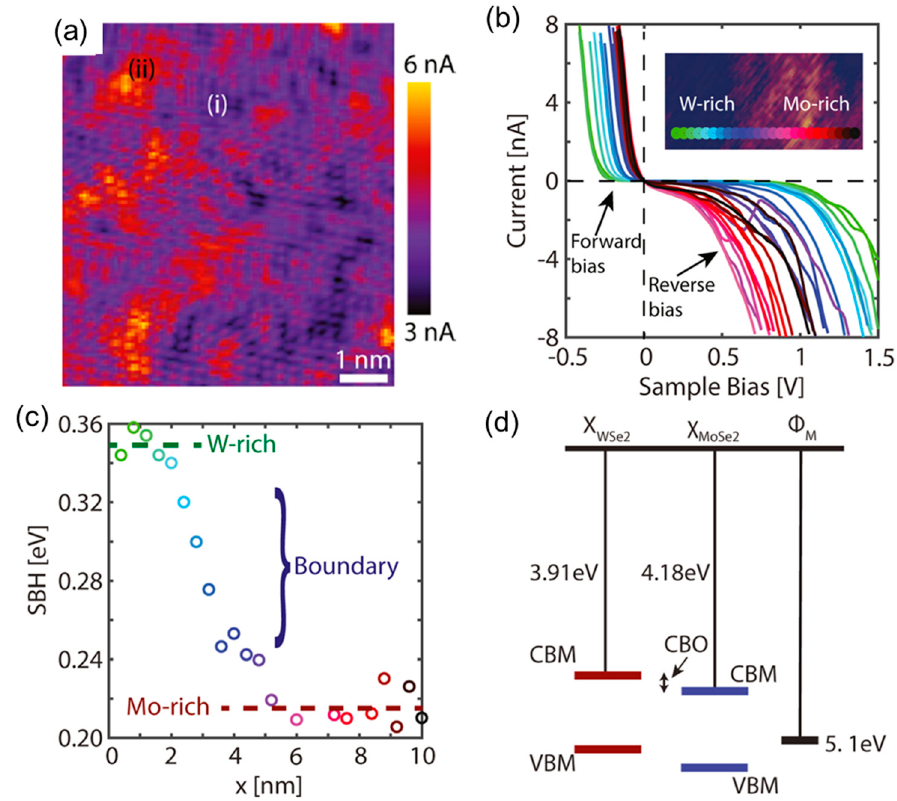
Figure 9. ( a ) C-AFM image of the surface of a Mo 0.3 W 0.7 Se 2 alloy, showing regions with different conductivities. ( b ) I-V characteristics across a W-rich/Mo-rich boundary (insert); the rainbow line indicates the positions where the I-V characteristics were recorded. ( c ) SBH as a function of the position along the line, with the color code corresponding to the exact I-V curves of panel ( b ). ( d ) Schematic band diagram of a WSe 2 /MoSe 2 lateral heterojunction, illustrating the conduction band minima (CBM) and valence band maxima (VBM) of WSe 2 and MoSe 2 and the conduction band offset (CBO). Images adapted with permission from Reference [69], copyright from the American Chemical Society 2018.